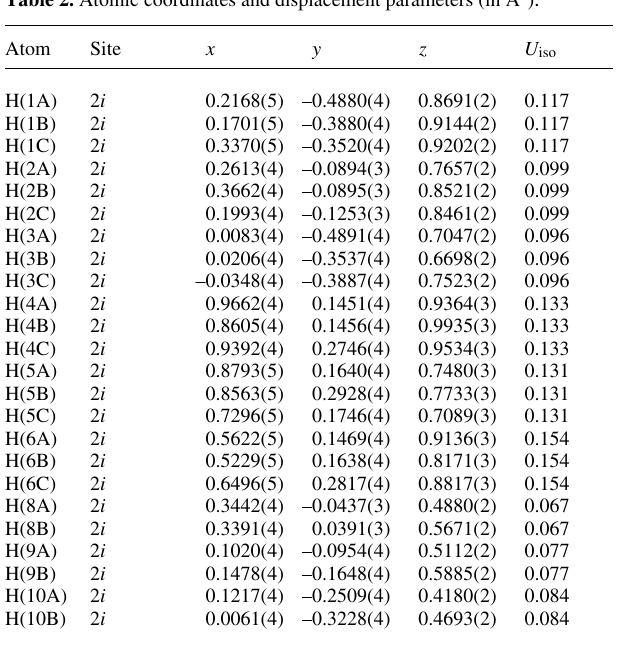
Table 2. Atomic coordinates and displacement parameters (in Å 2 )